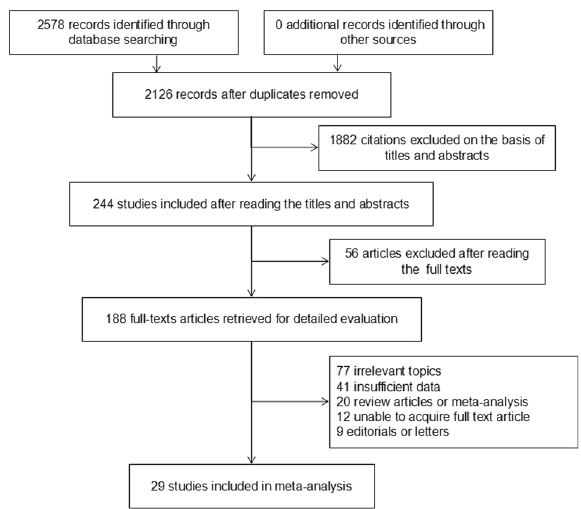
Fig. 1 Studies selection for meta-analysis. COPD chronic obstruc- tive pulmonary